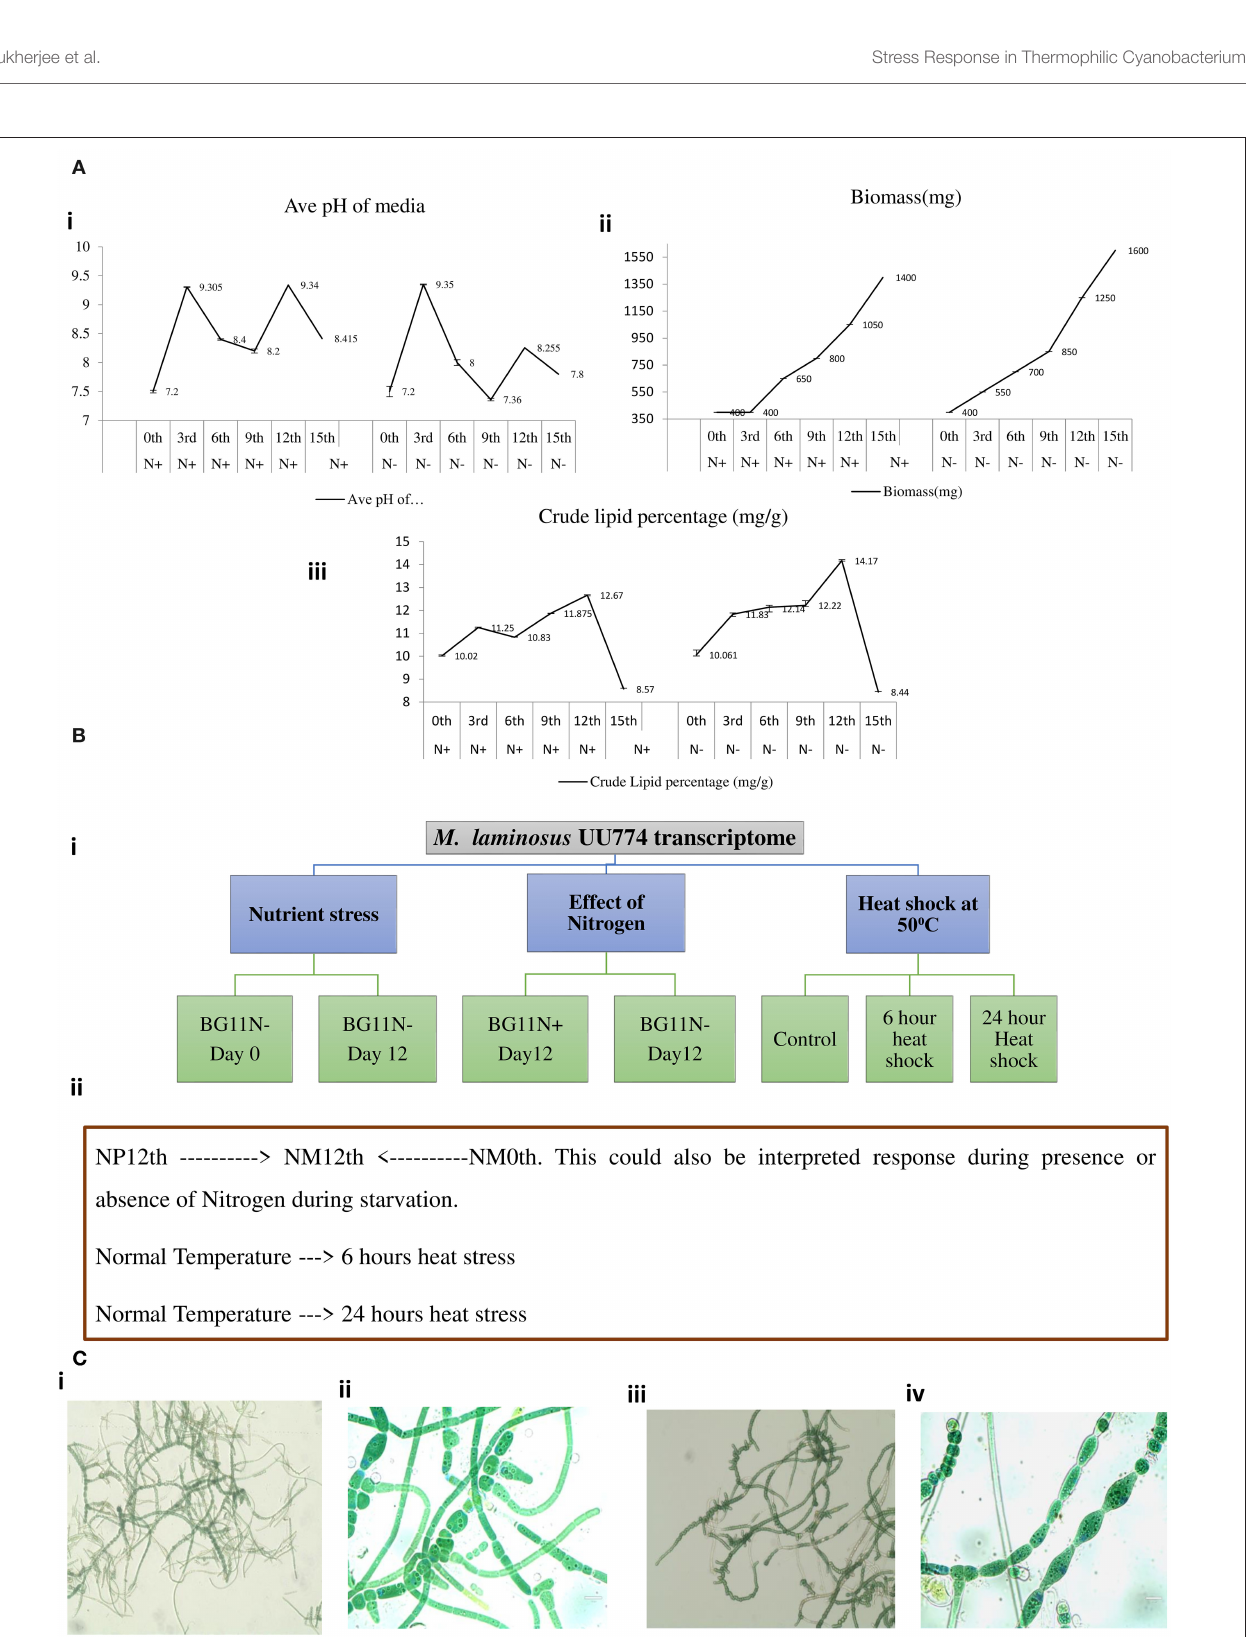
FIGURE 2 | A pilot experiment to determine the time point for metabolic switch. (A) (i) Cultures were grown in BGN– and BGN + media, and pH change of the media was noted. On the 3rd day of growing the cultures, there was a sharp peak for cultures grown in both the N– and N + media. This may be correlated with increased metabolism. On day 9, there was a fall in the pH, but it rose again on the 12 th day before declining further. All the experiments were repeated 3 times.